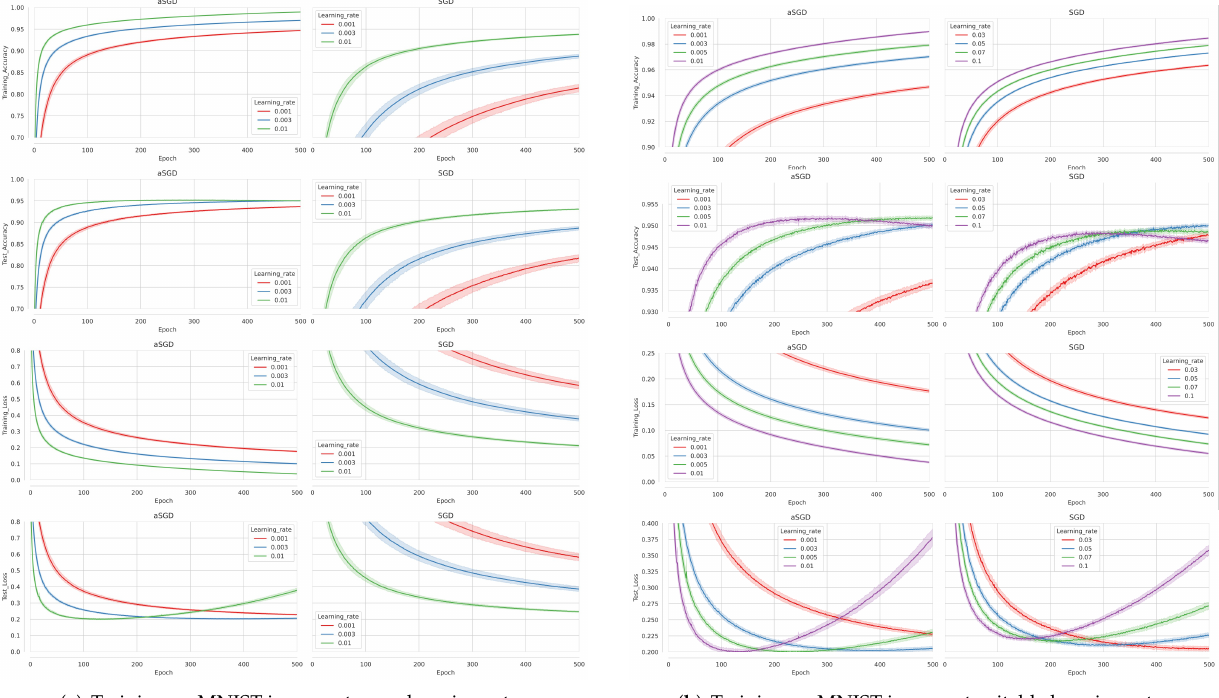
Figure 8. The learning curve of Experiment 3 for training on MNIST images at ( a ) same and ( b ) suitable learning rates using aSGD and SGD. Lines with buffers show the mean and 95% confidence